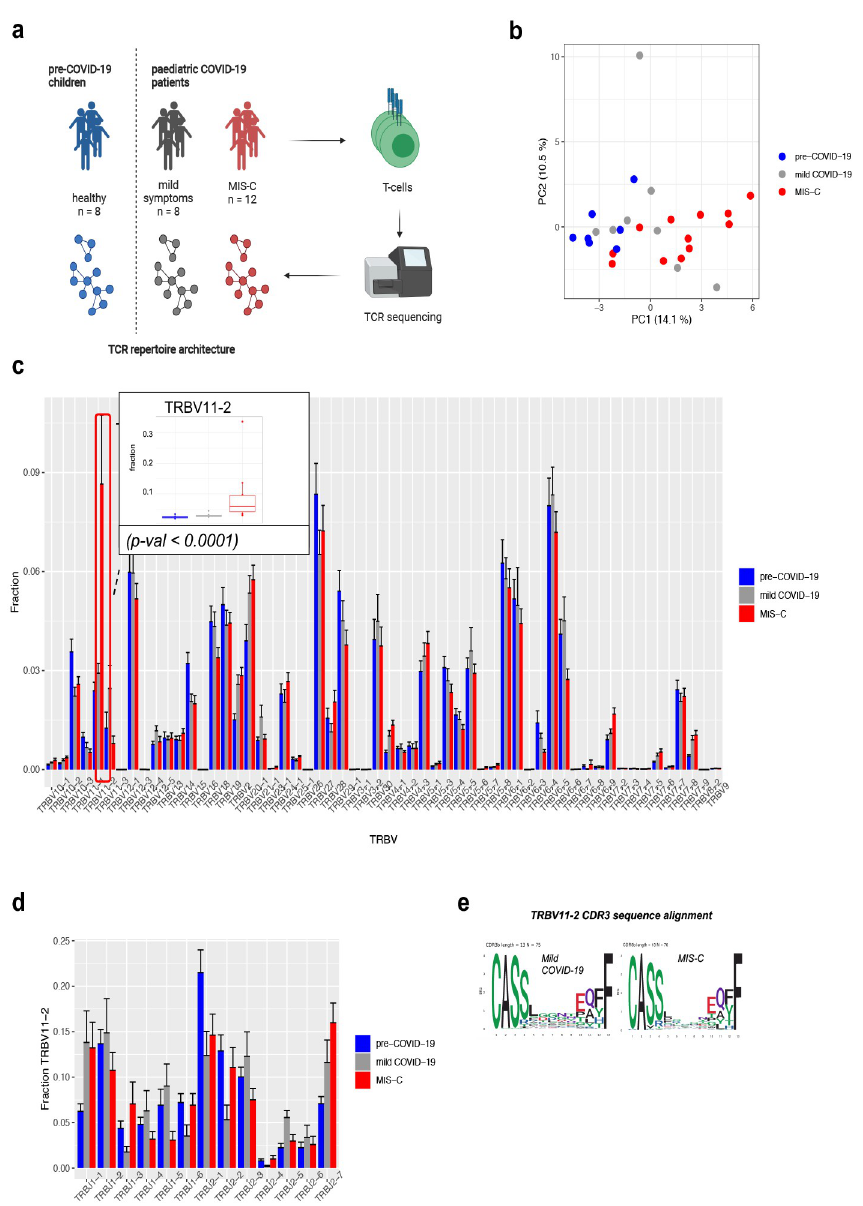
Fig 1. TRBV11-2 is expanded in the repertoire of children with MIS-C. (a) Overview of study design. (b) Principal component analysis (PCA) of differential TRBV usage in children with MIS-C (n = 12), children with mild symptoms (n = 9), and pre-COVID-19 children (n = 8). Values in brackets show the percentage of variation explained by each principal component. (c) Frequencies of TRBV genes in the patient cohorts. Bars indicate mean + SEM. Insert: TRBV11-2 usage in patient cohorts. Differential gene expression analysis of TRBV genes was conducted using the EdgeR package. TRBV11-2 is expanded in MIS-C compared to children with mild symptom (p-val < 0.0001). (d) Differential usage of J genes rearranged with TRBV11-2. Bars indicate mean + SEM. TRBV11-2 rearrangement frequencies were analysed using the EdgeR package. (e) CDR3 diversity of TRBV11-2 in children with mild disease and MIS-C displayed as positional weight matrix. CDR3 sequences containing 13 amino acids are shown as examples.